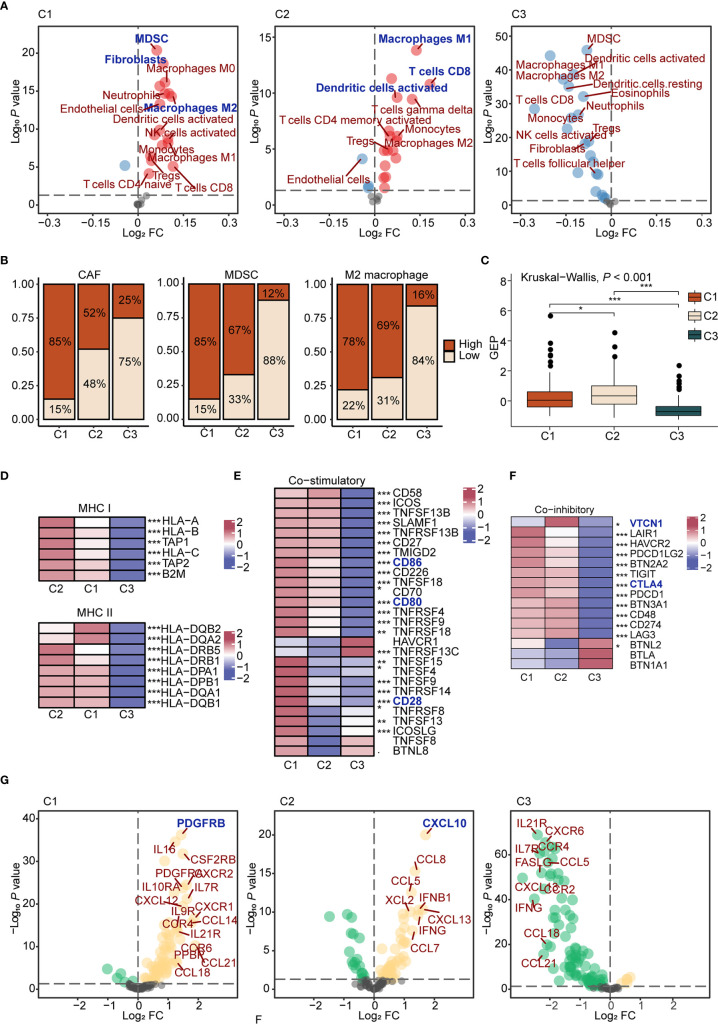
The characteristics of immune microenvironment of immunometabolism subtypes (A) The volcano plots of enriched and depleted immune and stromal cells for each subtype compared with other subtypes with limma package. Red: enriched; Blue: depleted. (B) Patients were classed according to the median infiltration scores of immunosuppressive cells (CAFs, MDSC, and M2 macrophages), and the percentages of the high score group and the low score group were calculated. (C) GEP scores differences in three subtypes. The differences were compared using the Kruskal-Wallis test. (D) Differences of MHC molecules expression level in three subtypes. The differences among each subtype were compared by Kruskal-Wallis test. (E, F) Differences of co-stimulatory (E) and co-inhibitory (F) molecules expression level in three subtypes. (G) The volcano plots of enriched and depleted expression of chemokines and cytokines for each subtype compared with other subtypes with limma package. Yellow: enriched; Green: depleted. The differences among each subtype were compared by Kruskal-Wallis test. (*P < 0.05; **P < 0.01; ***P < 0.001).